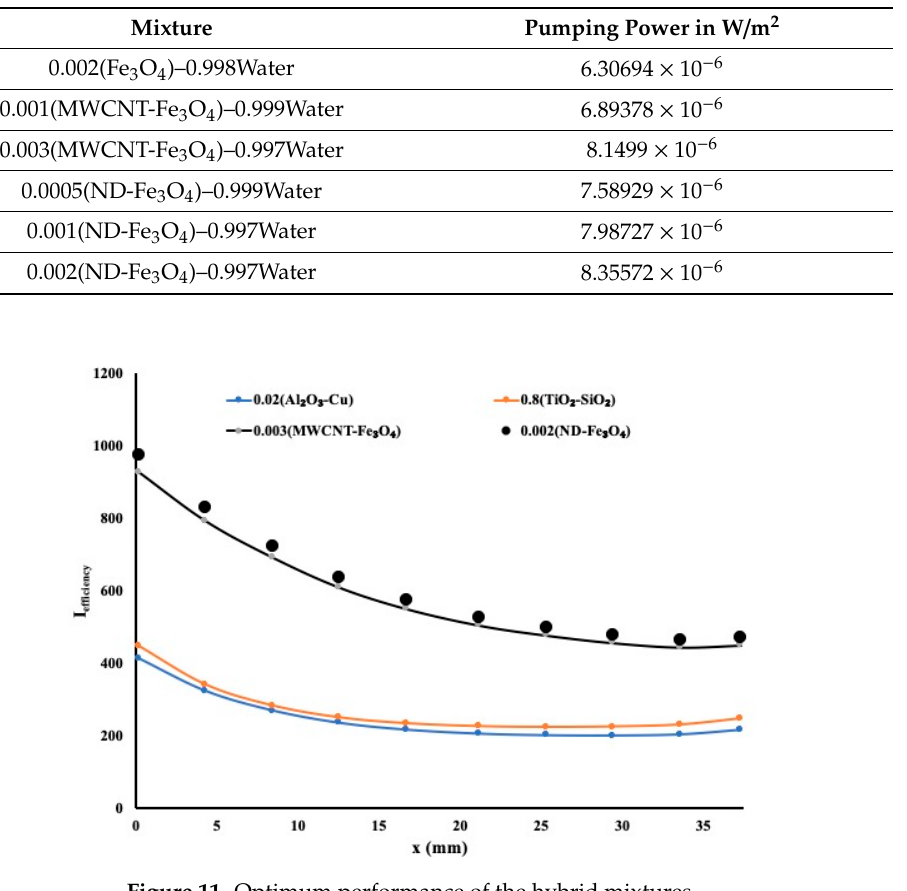
Figure 11. Optimum performance of the hybrid mixtures.